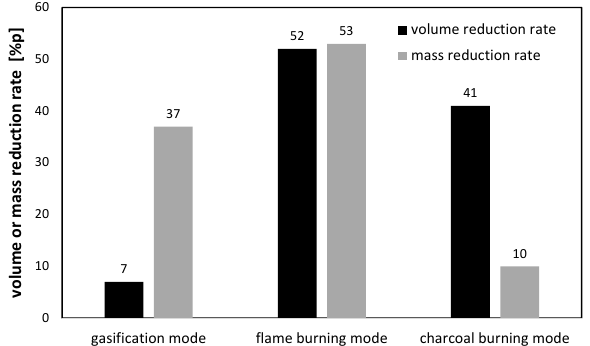
Figure 13. Residual mass ratio by off-line and on-line measurement with respect to elapsed time and previous research data by Biswas [18].